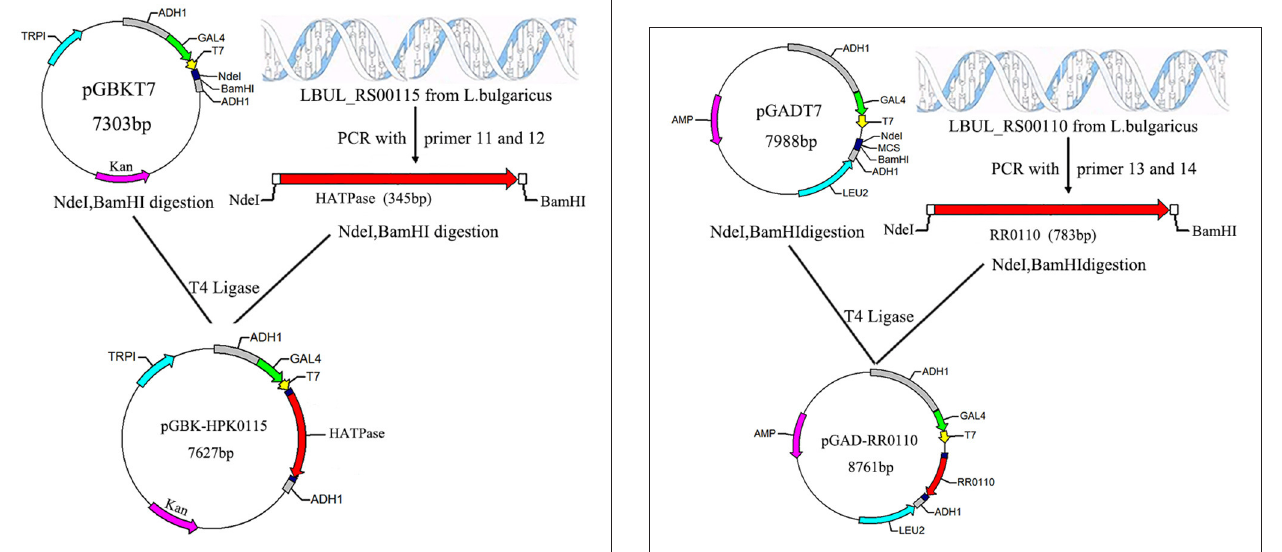
FIGURE 3 | Construction of recombinant plasmid pGBK-HPK0115. The red arrow represents the LBUL_RS00115 gene fragment from L. bulgaricus ATCC BAA-365; The magenta arrow represents the kanamycin resistance gene; NdeI, BamHI are endonuclease hydrolysis sites.